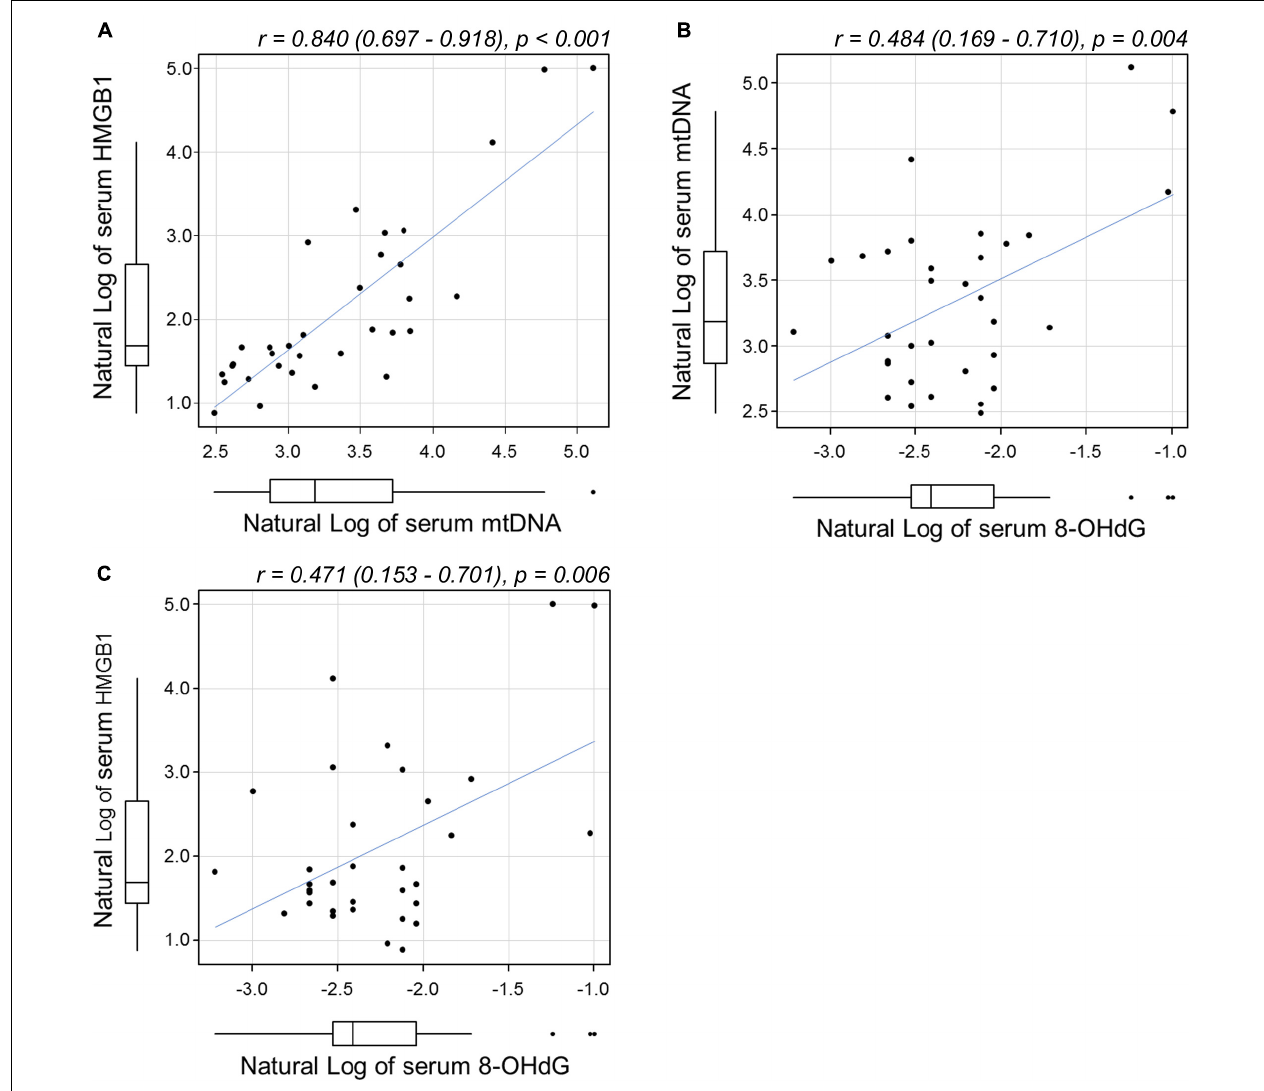
FIGURE 3 | Scatterplots showing the relationship between (A) serum mtDNA and HMGB1, (B) mtDNA and 8-OHdG, and (C) HMGB1 and 8-OHdG levels by Pearson correlation analysis. All variables were natural log transformed. (A) A significant correlation was found between serum mtDNA and serum HMGB1 levels [ r = 0.84 (0.697–0.918), p < 0.001]. Weak correlations were found between (B) mtDNA and 8-OHdG [ r = 0.484 (0.169–0.971), p = 0.004] and between (C) HMGB1 and 8-OHdG [ r = 0.471 (0.153–0.701), p = 0.006]. mtDNA, mitochondrial DNA; HMGB1, high-mobility group box (HMGB) 1; 8-OHdG, 8-hydroxy-2 (cid:48)